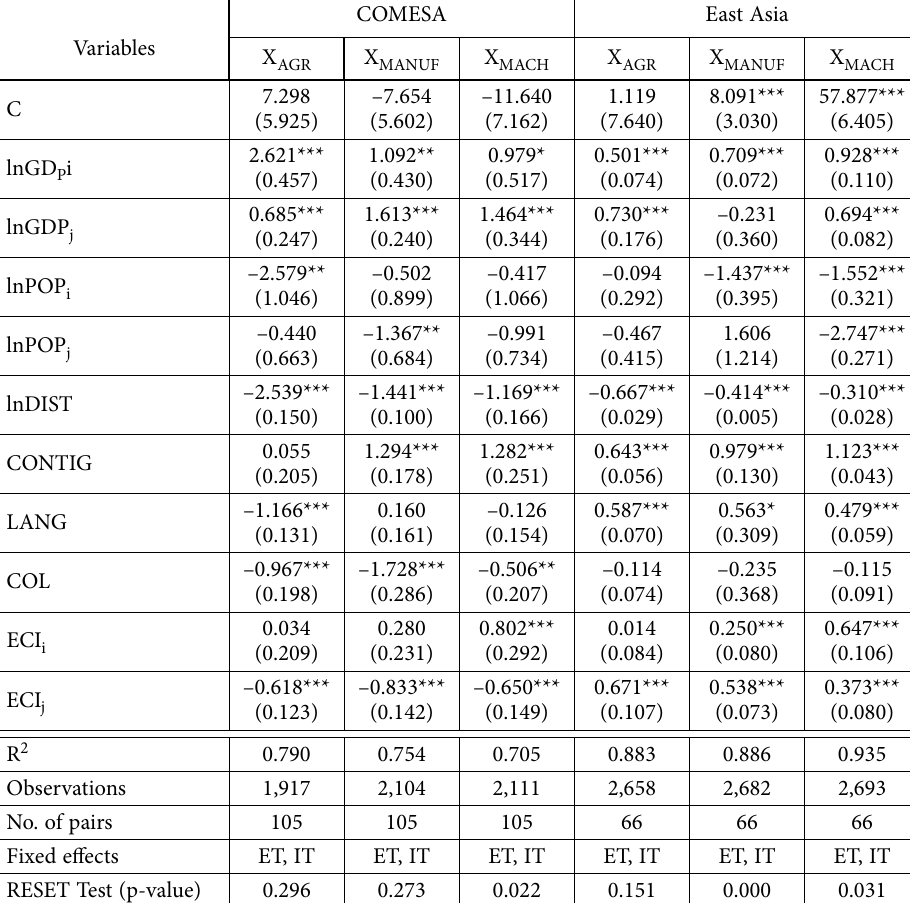
Table 4. Gravity model estimates of bilateral exports using PPML by